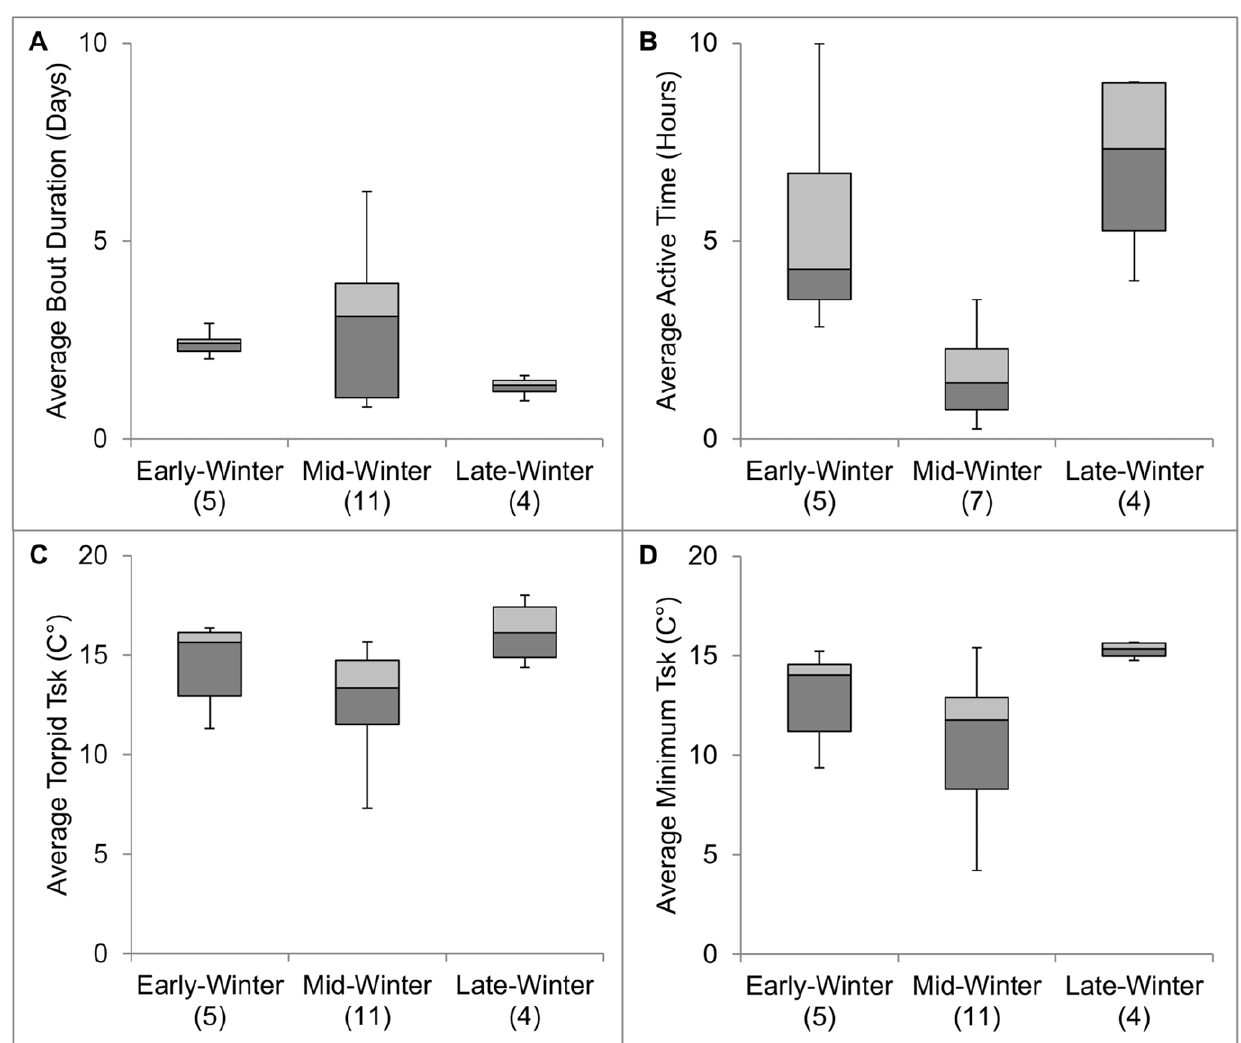
Figure 2. Winter torpor behaviors of Rafinesque’s big-eared bats during early (mid-November–mid-December), mid- (mid- December–mid-February), and late (March) winter determined through radio-telemetry at Mammoth Cave National Park, Kentucky, USA. Number of radio-tagged bats is included in parentheses.